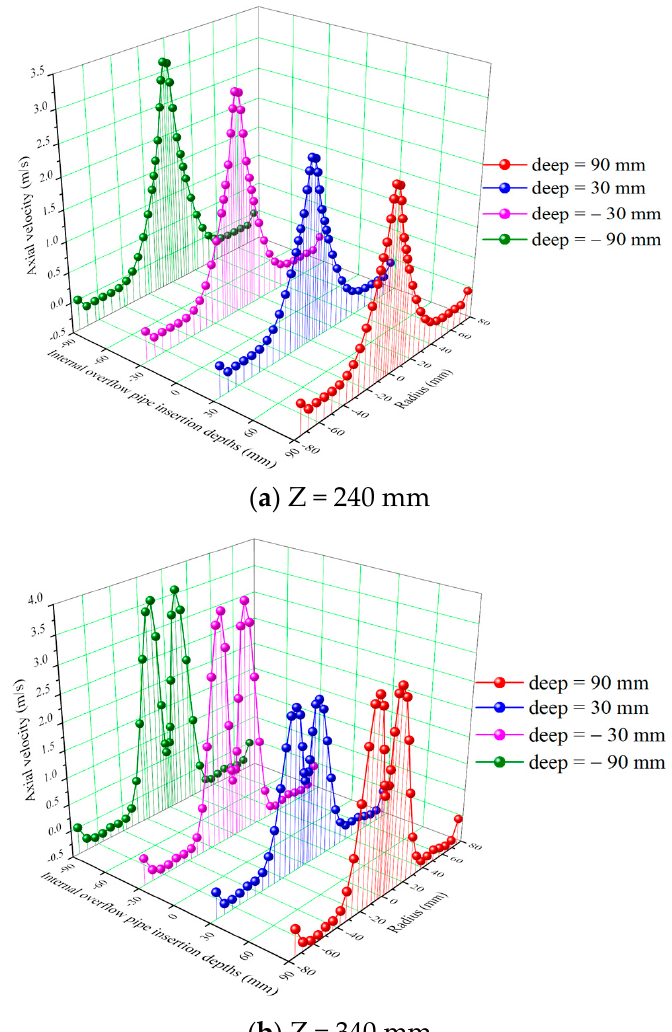
Figure 8. Axial velocity distribution in different inner vortex finder insertion depths.